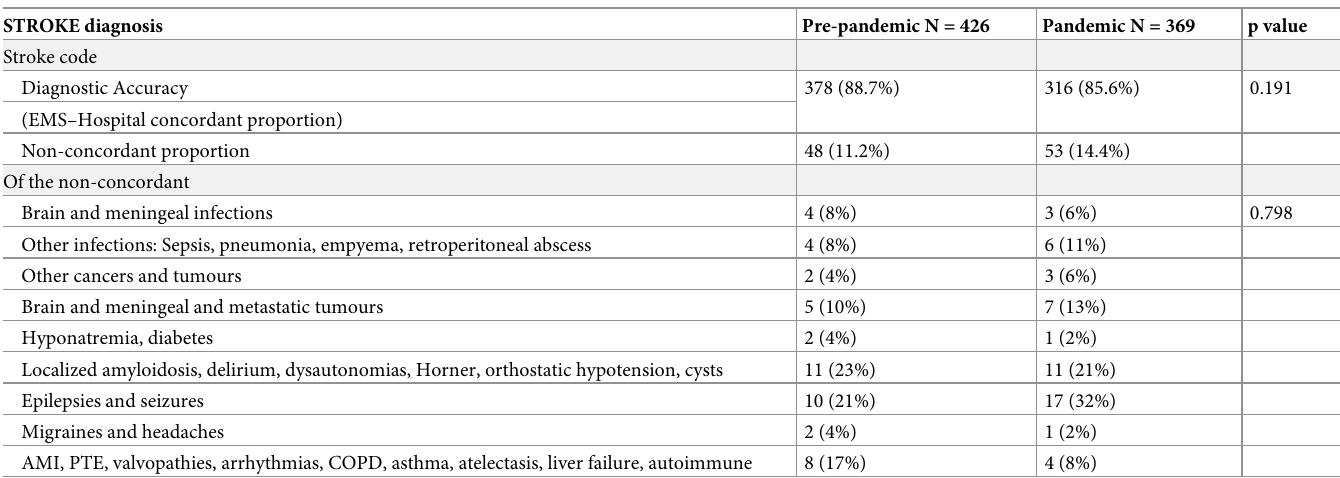
Table 3. Diagnoses at hospital